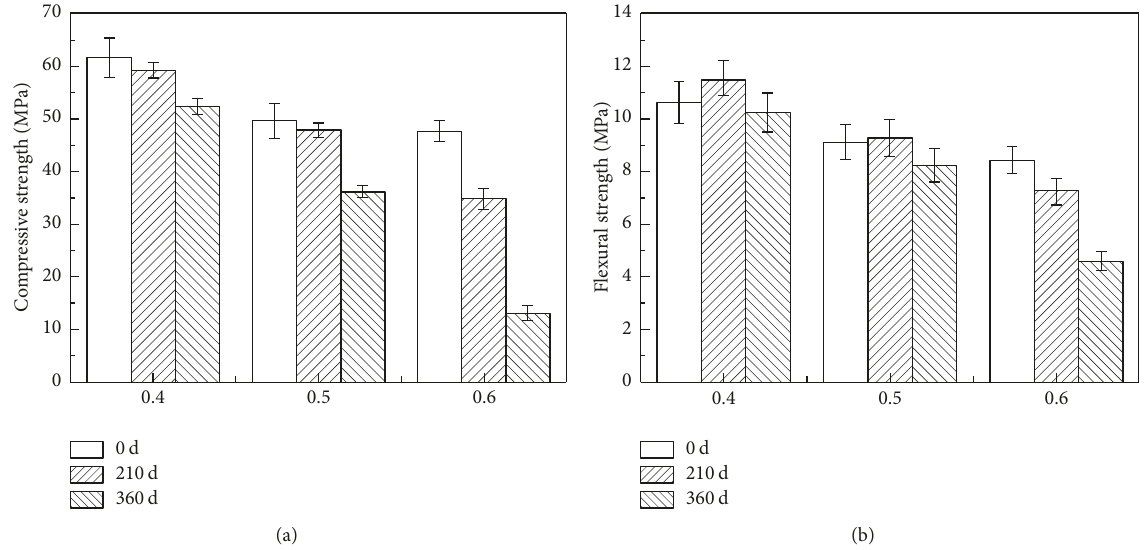
Figure 3: Strength development of mortars with different water-to-cement ratios with immersion time: (a) compressive strength, (b) flexural strength.